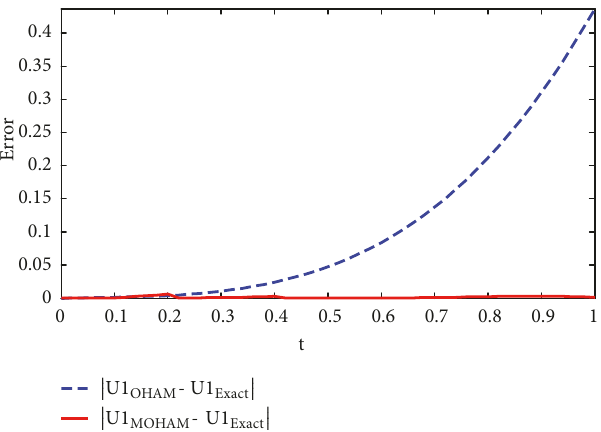
Figure 3: Absolute errors of OHAM and MOHAM for u1 in Example 1.